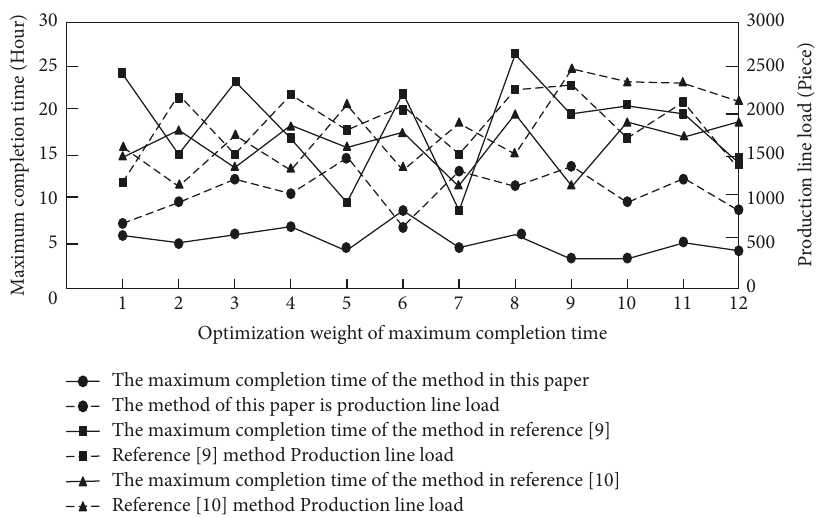
Figure 7: Comparison of maximum completion time weights of the multiproduction line scheduling.